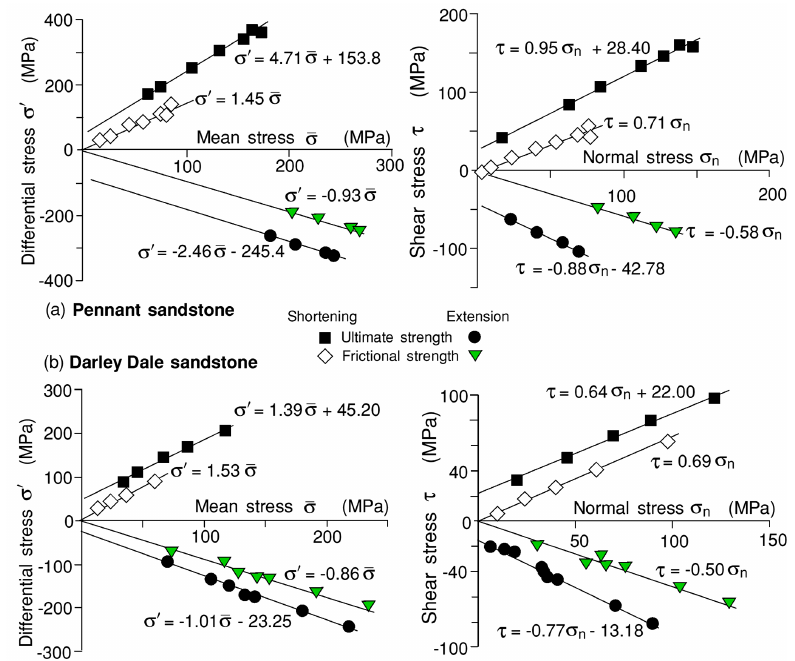
Figure 4. Summary of results of experiments on intact rock cylinders in axisymmetric extension and shortening, for ultimate strength and residual strength (frictional sliding on fault plane formed). Data are shown as differential stress versus mean stress and as resolved normal and shear stress on the fault plane orientation for each rock type. Shear stress and differential stress are shown as negative for extension tests. Errors of measurement are generally smaller than the size of the points